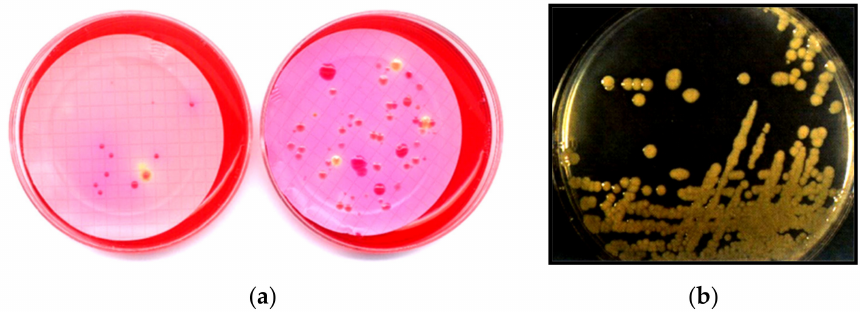
Figure 4. Growth of bacteria on: ( a ) GSP agar; ( b ) TSA agar.